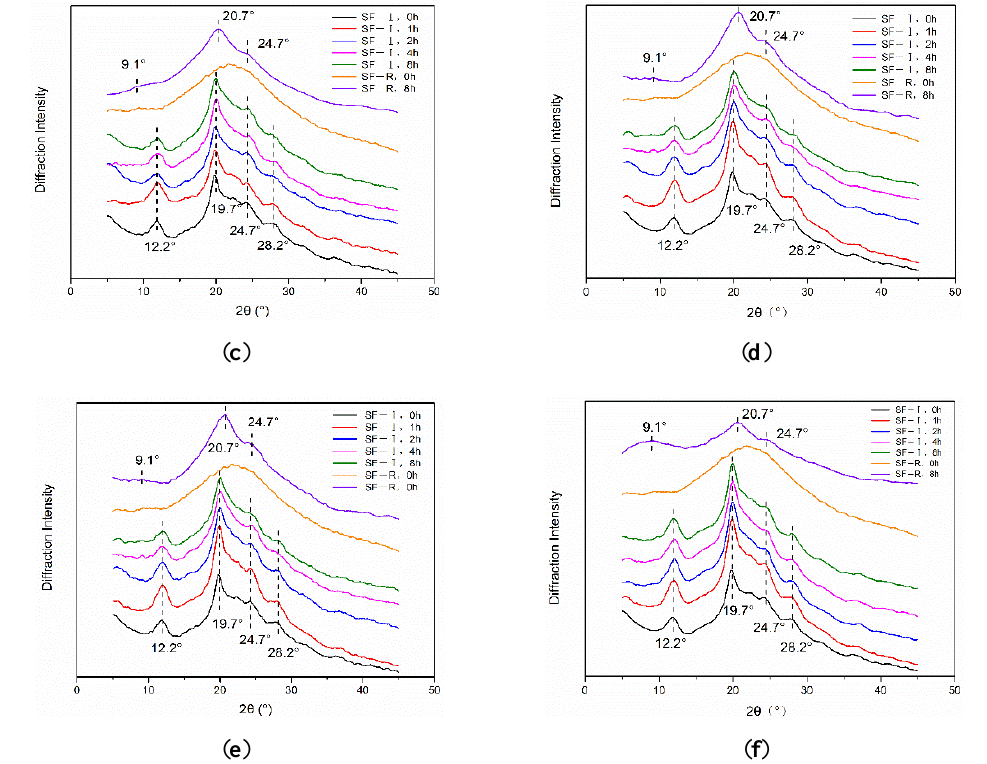
Figure 2. X-ray diffraction (XRD) analysis of SF-I and SF-R materials before and after alcohol treatment: ( a ) 75% methanol, ( b ) 90% methanol, ( c ) 99% methanol, ( d ) 75% ethanol, ( e ) 90% ethanol, ( f ) 99% ethanol.